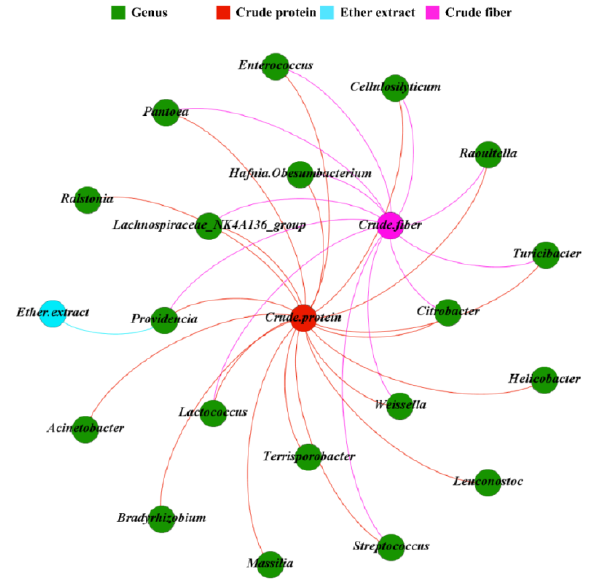
Figure 5. Network analysis between the top 30 genera and nutrient digestibility in giant pandas. The nodes were colored according to nutrient digestibility and genus. Only correlations with Spearman’s coefficient r > 0.5 and p < 0.05 are shown.